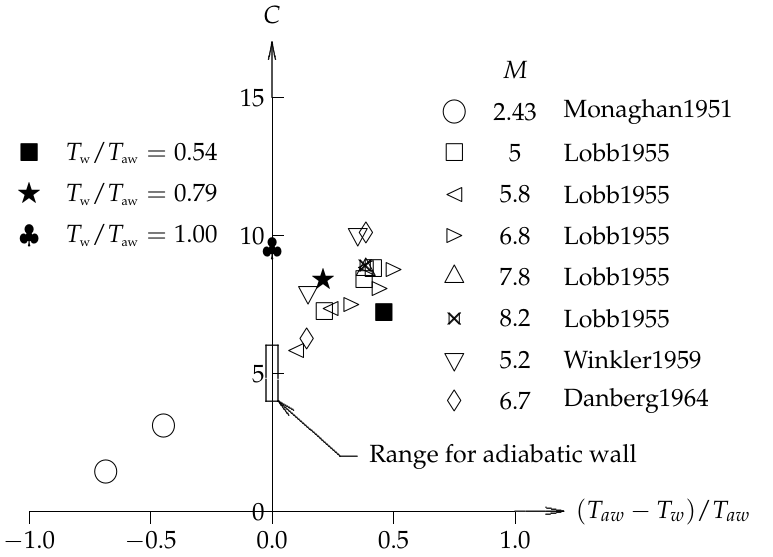
Figure 10. Relation of constant C in the logarithmic region with wall temperature (Danberg [32]). Table 4. Effect of wall temperature on boundary layer displacement and momentum thickness.